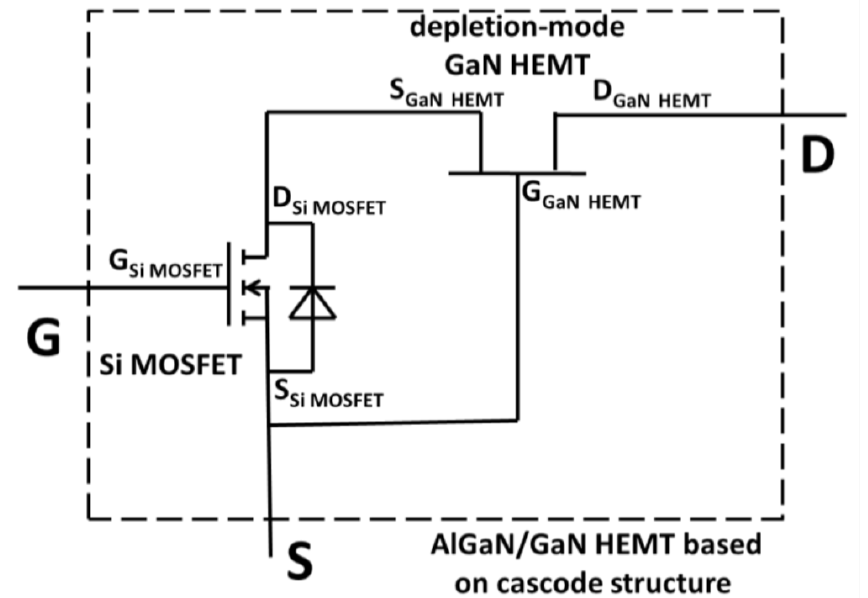
Figure 1. The schematic of aluminium gallium nitride /gallium nitride high electron mobility transistor (AlGaN/GaN HEMT), based on the cascode